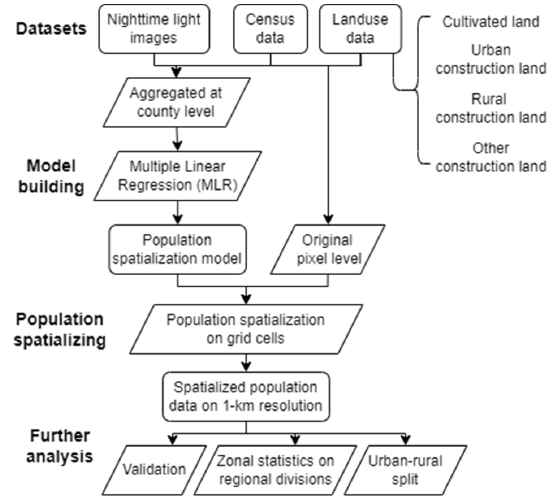
Figure 6. General flow chart of this study.